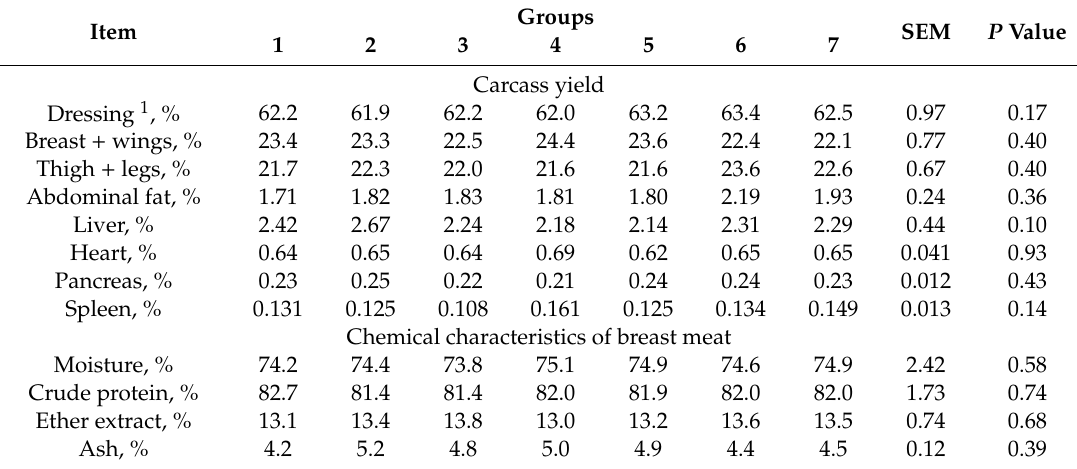
Table 4. Carcass yield, body organs percentage and breast meat chemical composition (Trial